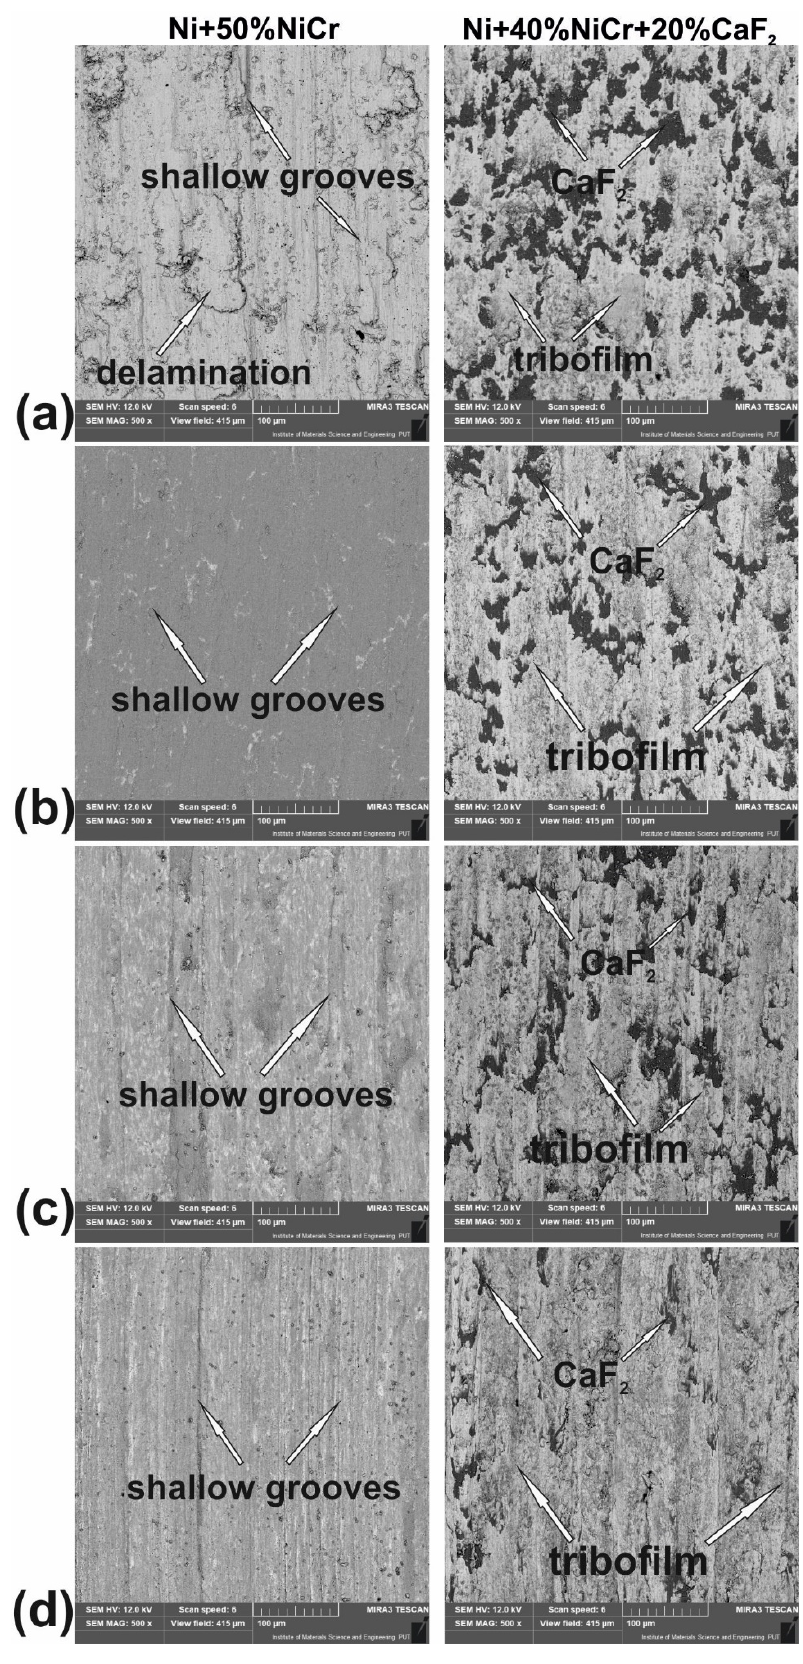
Figure 15. Surface condition of the sintered Ni-50%NiCr(80/20) and Ni-40%NiCr(80/20)-20%CaF 2 after wear test at room temperature, ( a ) at 200 °C, ( b ) at 400 °C, ( c ) at 600 °C, and ( d ) (SEM).